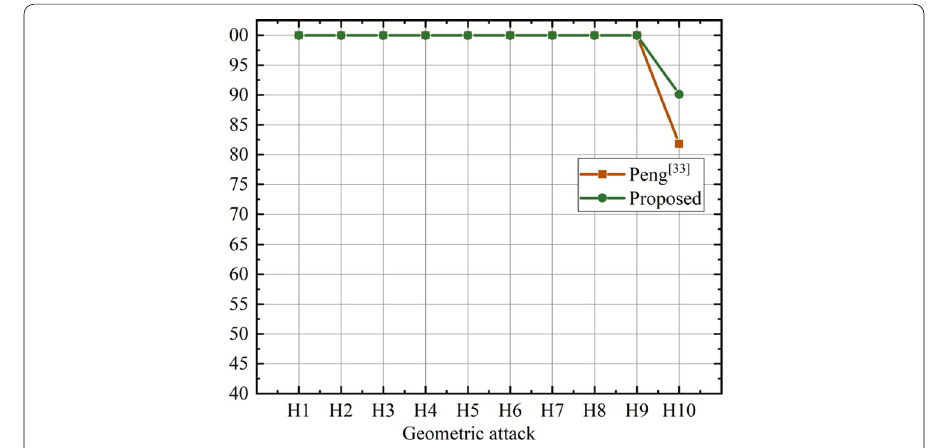
Fig. 10 Robustness comparison on the MICC‑F220